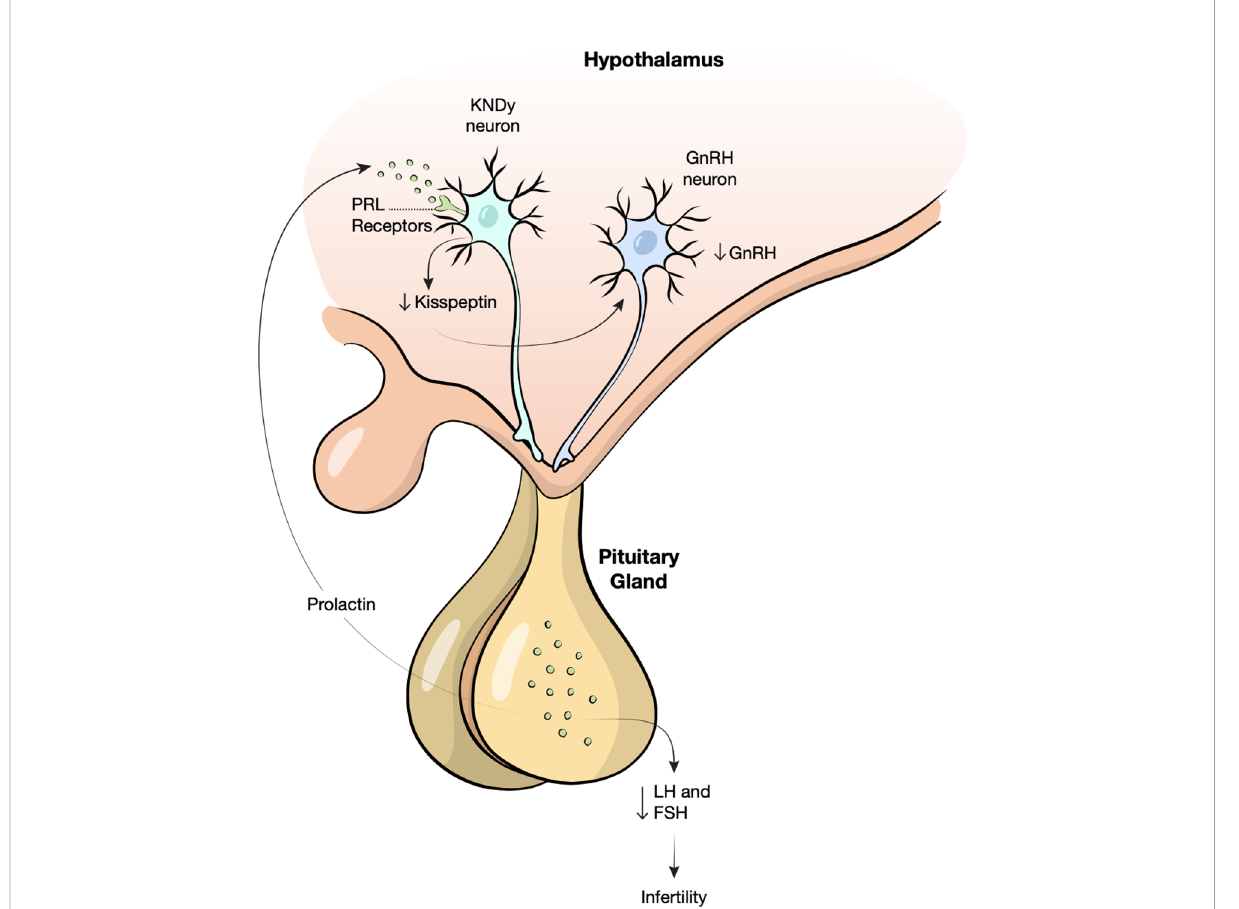
FIGURE 2 Proposed mechanism of hyperprolactinemia induced infertility. Prolactin (PRL) binds receptors on kisspeptin, neurokinin B, and dynorphin neurons (KNDy) in the hypothalamus, decreasing the release of Kisspeptin. Low kisspeptin may cause loss of gonadotropic releasing hormone (GnRH) pulsatility resulting in decreased follicle stimulating hormone (FSH) and luteinizing hormone (LH) and therefore infertility.